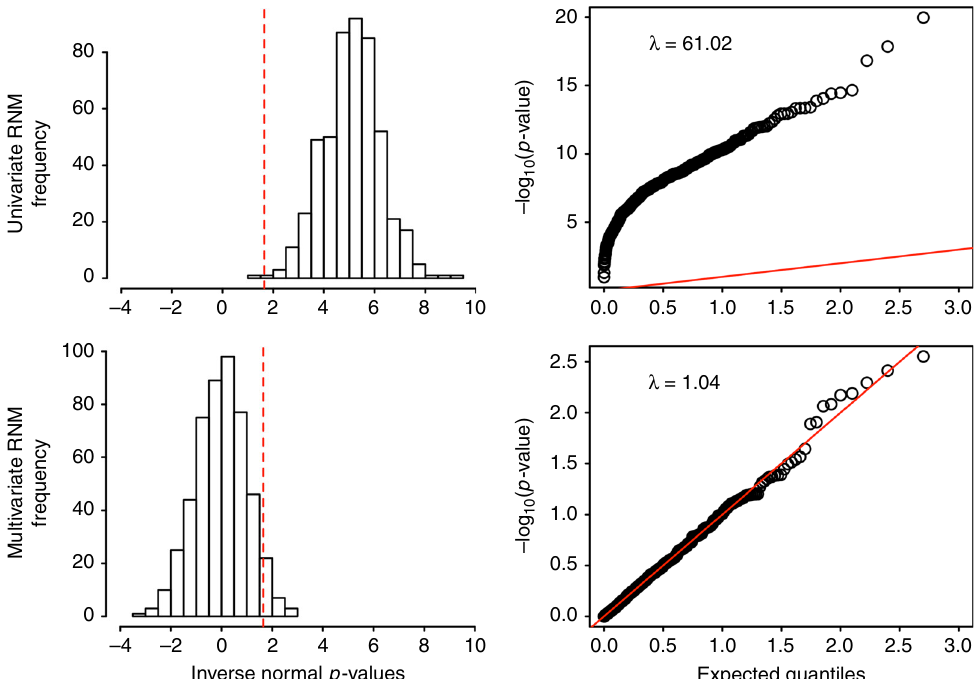
Fig. 4 Spurious signals generated by incorrect (univariate) model can be controlled by MRNM. Five hundred replicates of data were simulated under a null model that assumed genotype – covariate correlation but no genotype – covariate interaction. Simulation was based QCed ARIC data consisting 7,263 individuals and 583,058 SNPs. The model is speci fi ed as y = α 0 + α 1 × c + e with c = β + ε , all effects drawn from a multivariate normal distribution, where the variance – covariance structure between α 0 , β , and α 1 (in this order) is . For every replicate,